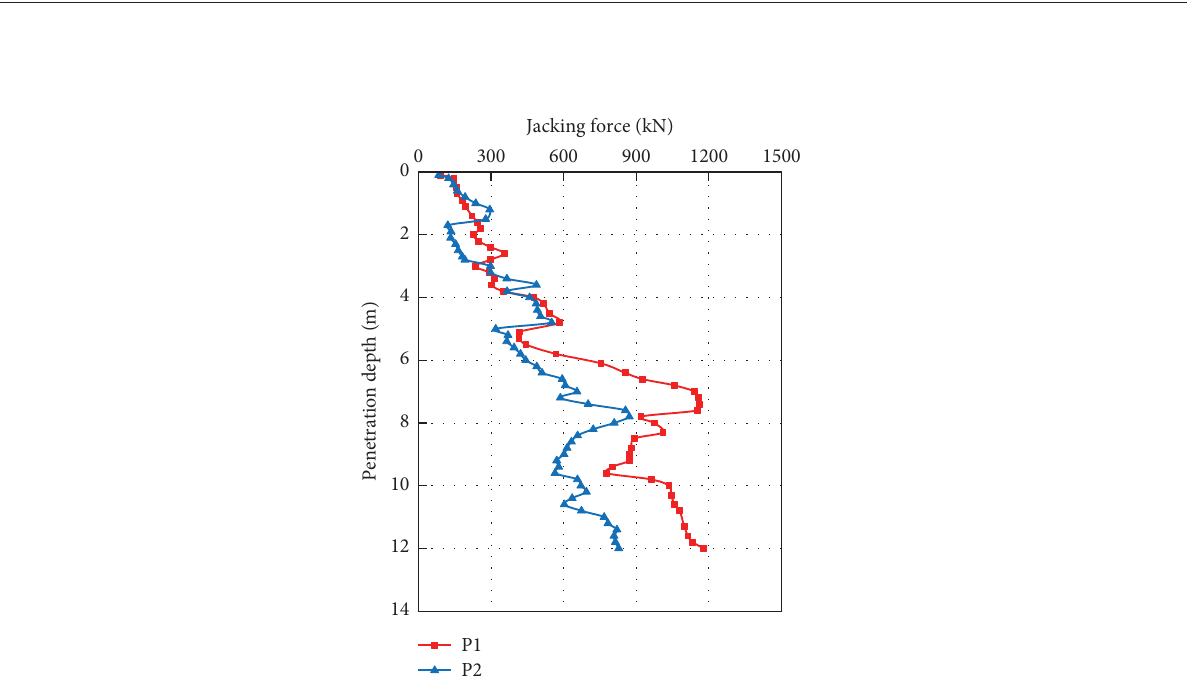
Figure 3: Jacking force versus penetration